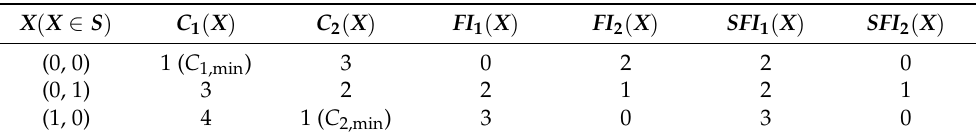
Table 2. Example of the optimization with the Min-Max Principle of Optimality (MMPO): data preparation.